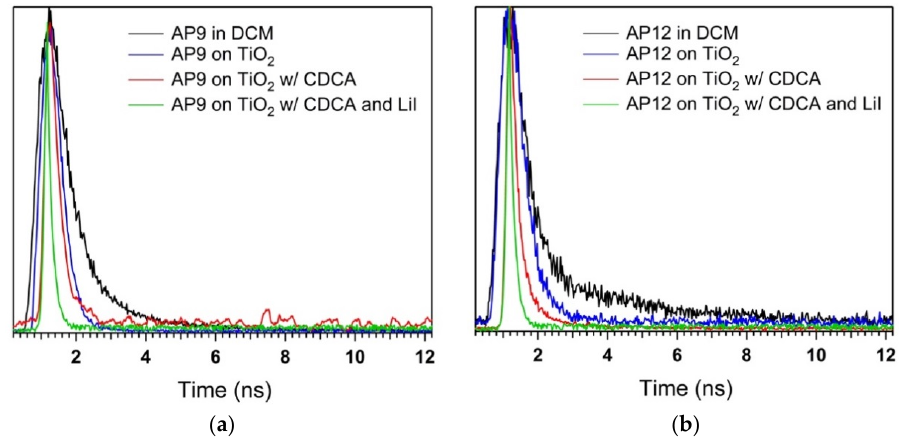
Figure 6. Fluorescence lifetimes of ( a ) AP9 and ( b ) AP12 in different environments.